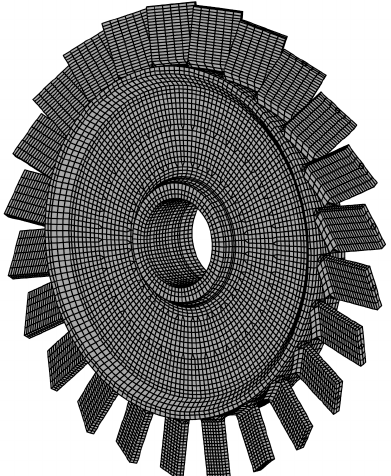
Figure 2. Rotor A with 24 blades and approximately 5800 DOF per